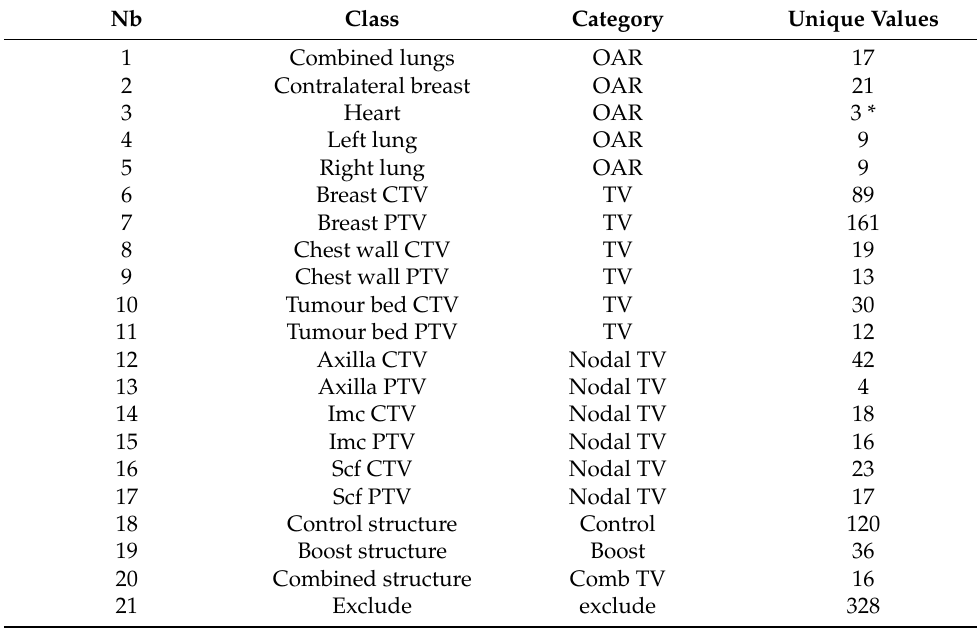
Table 1. Standardised labels and categories of the